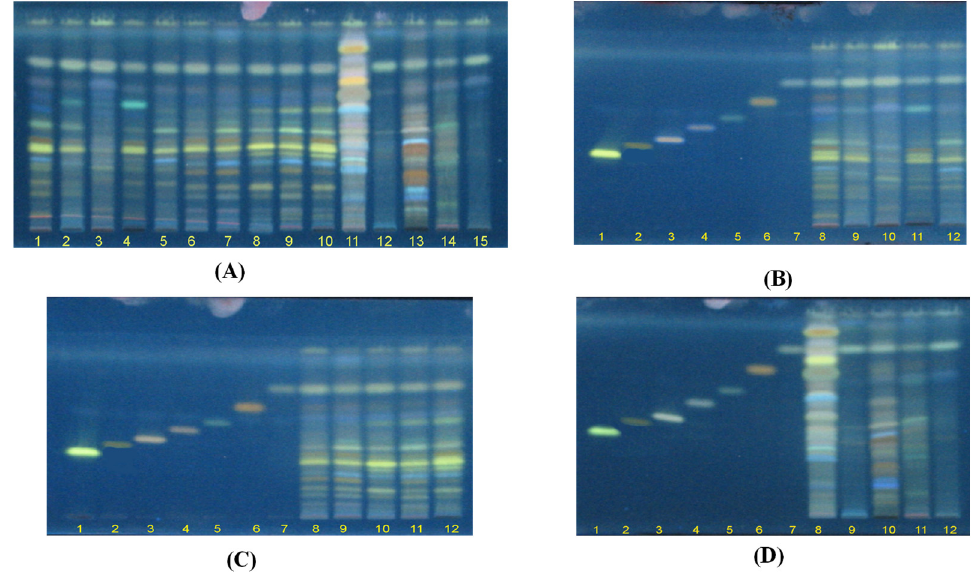
Figure 1. Chemical constituents isolated from wild-collected Linhzhi in Vietnam.